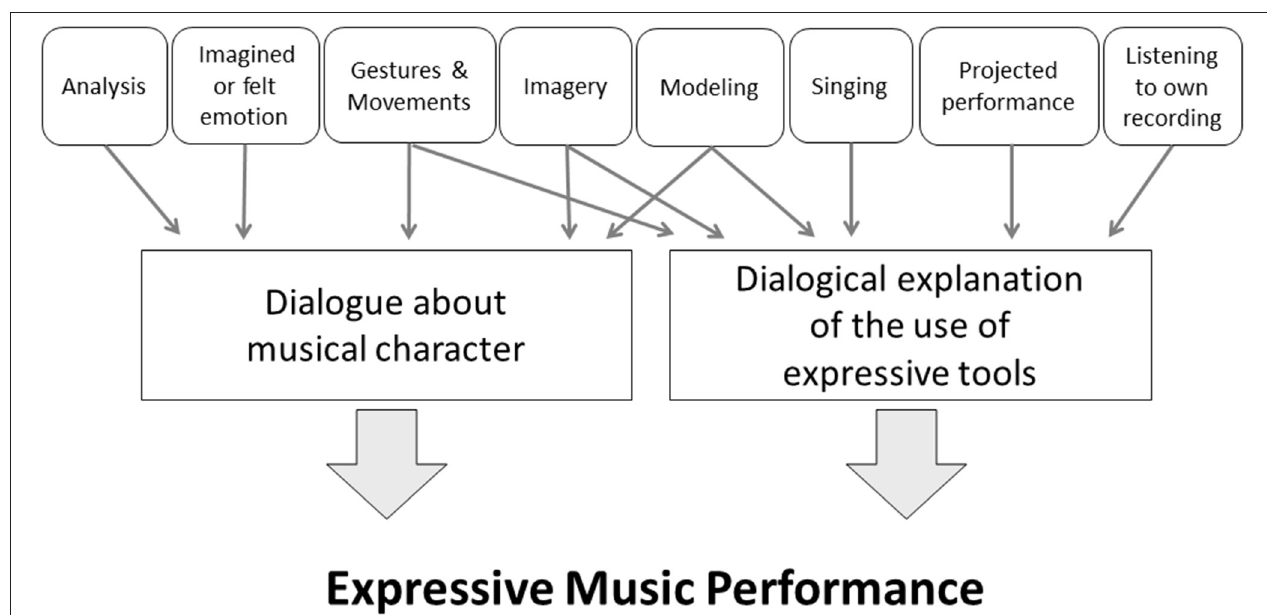
FIGURE 1 | Theoretic model for teaching and learning expressive music performance, incorporating supplemental strategies in support of the dialogic teaching of expressiveness.